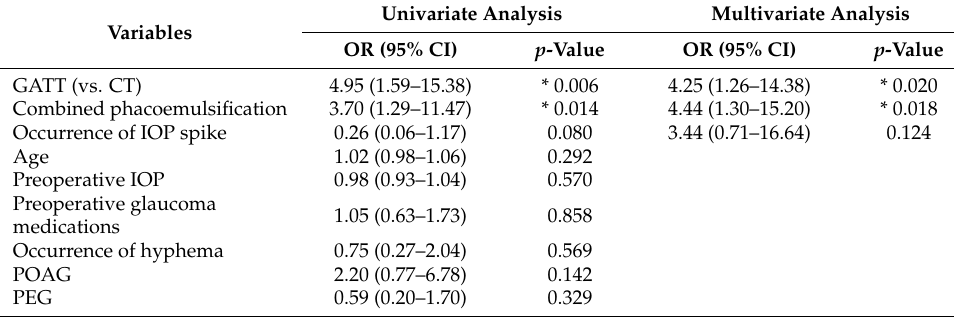
Table 6. Factors associated with the surgical success at 2 years